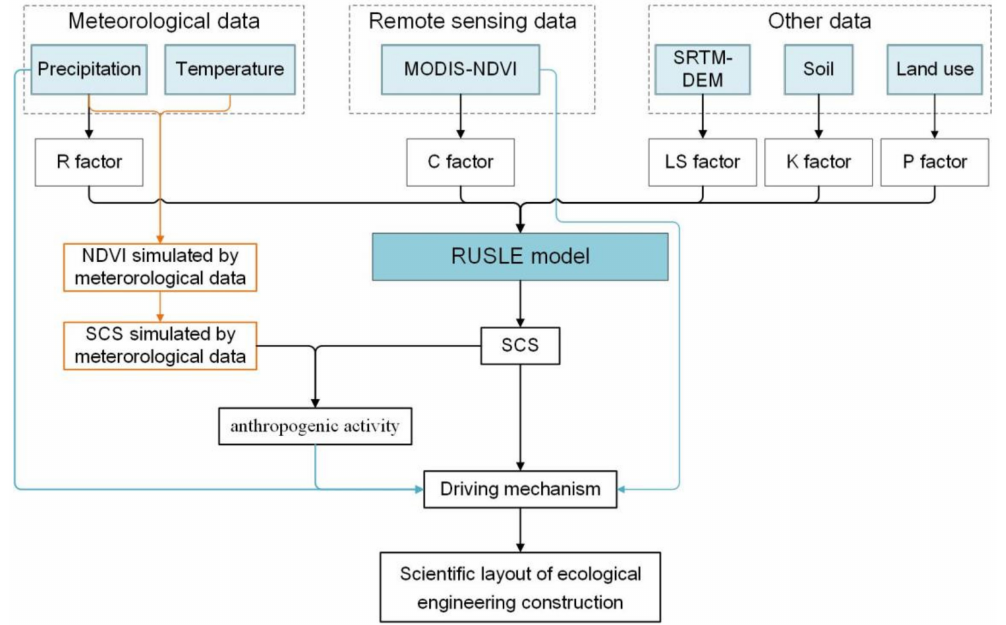
Figure 2. Methodological workflow chart adopted for evaluation of SCS.